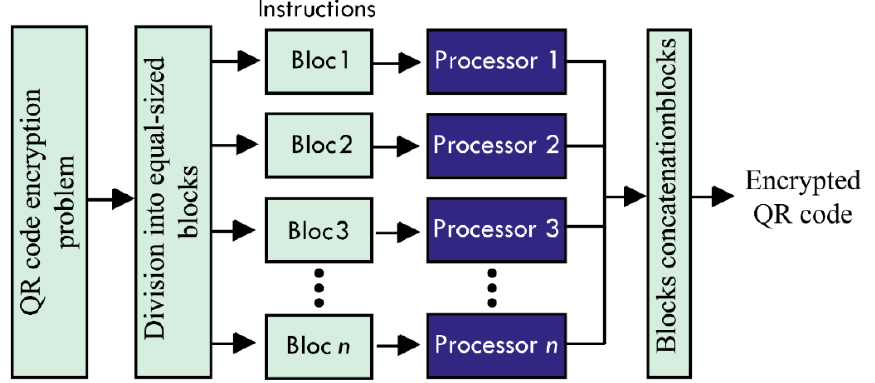
Figure 13. Proposed parallel encryption of the QR code using multi-core CPUs.